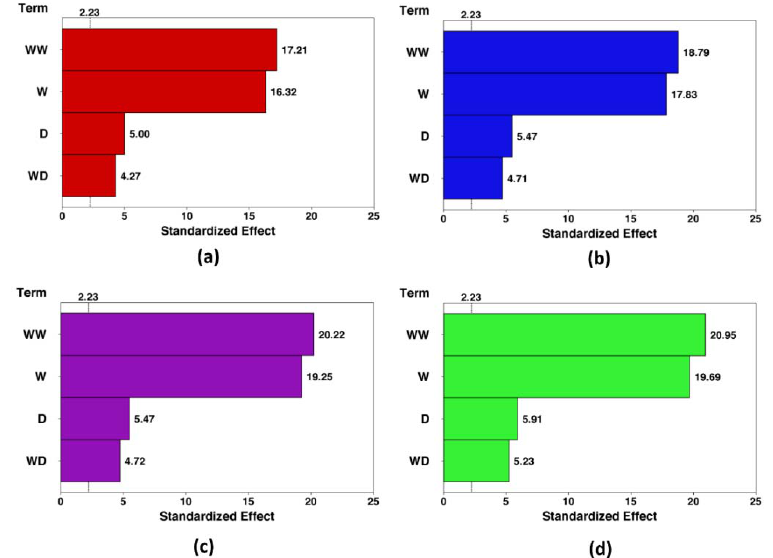
Figure 8. Pareto chart of the standardized effects (response is HTC, α = 0.05). ( a ): φ = 0%, ( b ): φ = 1%, ( c ): φ = 3%, and ( d ): φ = 5%.